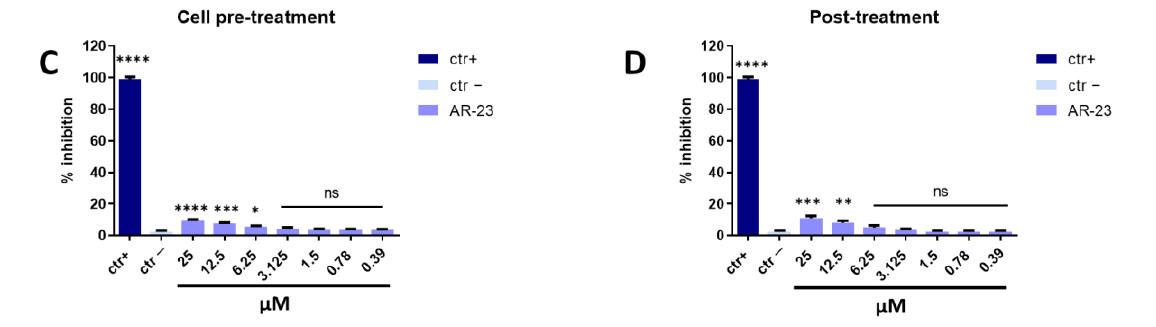
Figure 4. Antiviral activity against MeV. Different assays were performed in order to evaluate an- ti-MeV activity. ( A ) Co-treatment: simultaneous addition of AR-23 and virus to the cells; ( B ) Virus pre-treatment: virus incubated with the peptide, and then used to infect cells; ( C ) Cell pre-treatment: AR-23 incubated with the cells before the viral infection; ( D ) Post-treatment: AR-23 added to the infected cells. Peptide AR-23 inhibited the early stages of infection, acting in co-treatment ( A ) and virus pre-treatment ( B ) assays, while it was not able to interact with the cel- lular surface ( C ) or block the viral replication ( D ). Different compounds were used as positive control (ctr+) for each treatment: mucroporin M1 ( A , B , 10 μ M for both the assays) [40] , FIP peptide (C, 20 μ M) [41] , and 5′ -nor carbocyclic adenosine analogue (D, 5 μ M) [42] , while infected cells were used as negative control (ctr-). **** p < 0.0001; *** p < 0.0002; ** p < 0.0021; * p < 0.021; ns: non-significant.